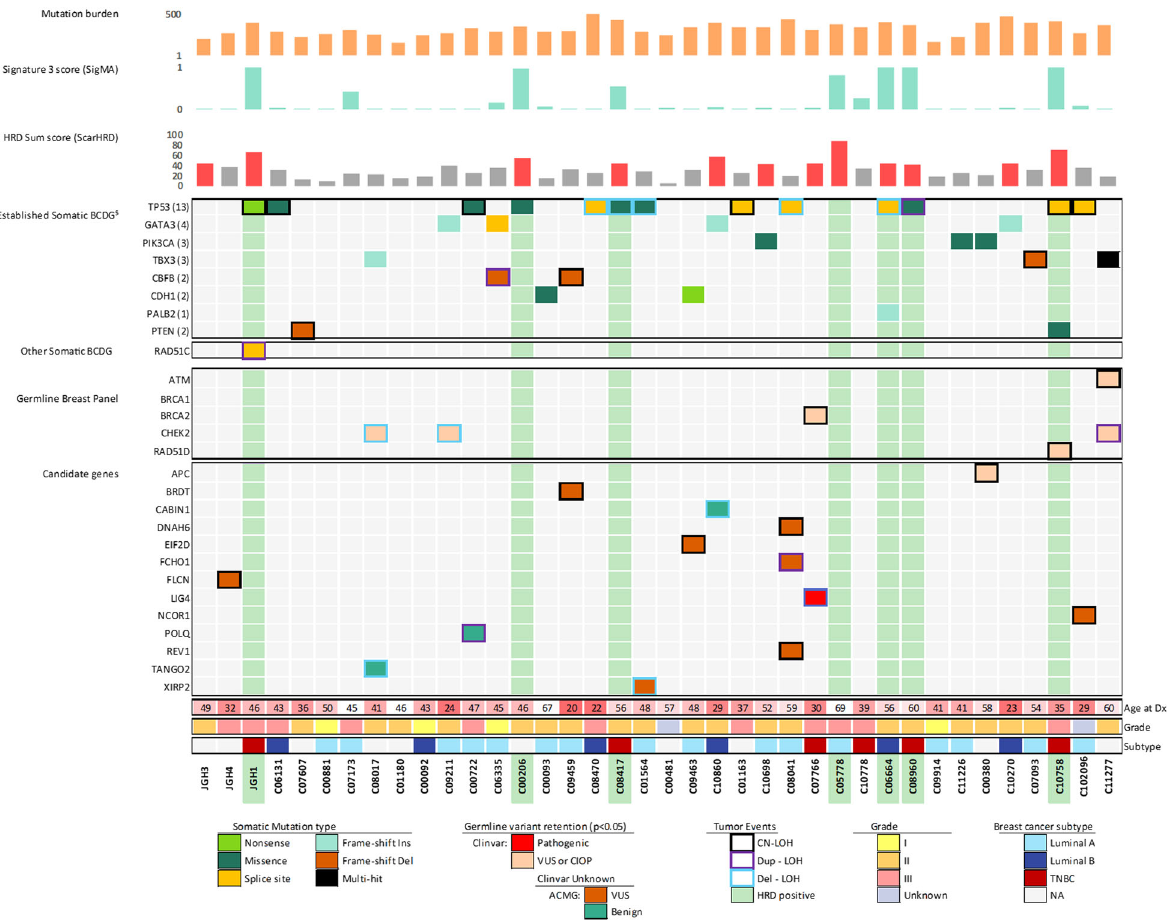
Fig. 2 Co-mutation plot of germline and somatic landscape after HRD detection. The HRD status evaluated by SigMA (that estimates the presence of Signature 3) is shown in the second row from the top, and columns with HRD based on SigMA are highlighted in vertical green columns. ScarHRD, shown in row 3, calculates the HRD index and cases with HRD determined by this method that has scores great than 41 are represented by red bars. The germline and somatic mutation status of candidate genes across patients are shown for four classes of genes (rows 4 – 7). BCDG: Breast Cancer Driver Gene; CN-LOH: copy neutral LOH; Dup-LOH: Duplication with LOH; Del-LOH: hemizygous deletion with